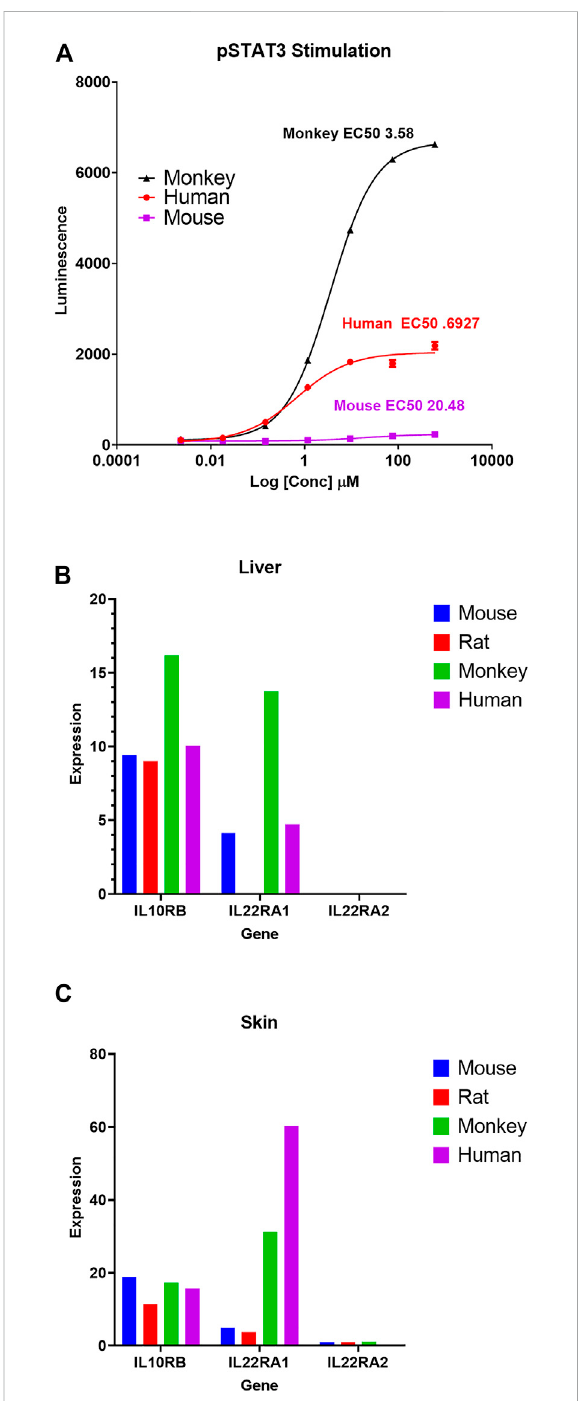
FIGURE 6 DifferentialpSTAT3stimulationandIL-22receptorgenesexpression across species. (A) pSTAT3 stimulation dose curves in response to recombinant IL-22 (rIL-22) in mouse, rat, monkey, and human primary hepatocytes. Species-speci fi c rIL-22 was used for rat and mouse hepatocytes.rhIL-22wasusedformonkeyandhumanhepatocytes.For rat, there was no signal, so no value is shown in the graph (A) . Average FPKM expression of IL-22-receptor genes (IL10R β , IL-22RA1, and IL- 22RA2) in Liver (B) and Skin (C) for mouse, rat, monkey, and human. Additional details on this case example are summarized in Table